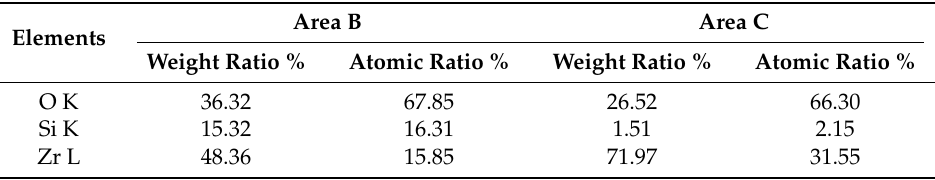
Table 1. The energy dispersive spectroscopy (EDS) results of area B and C in Figure